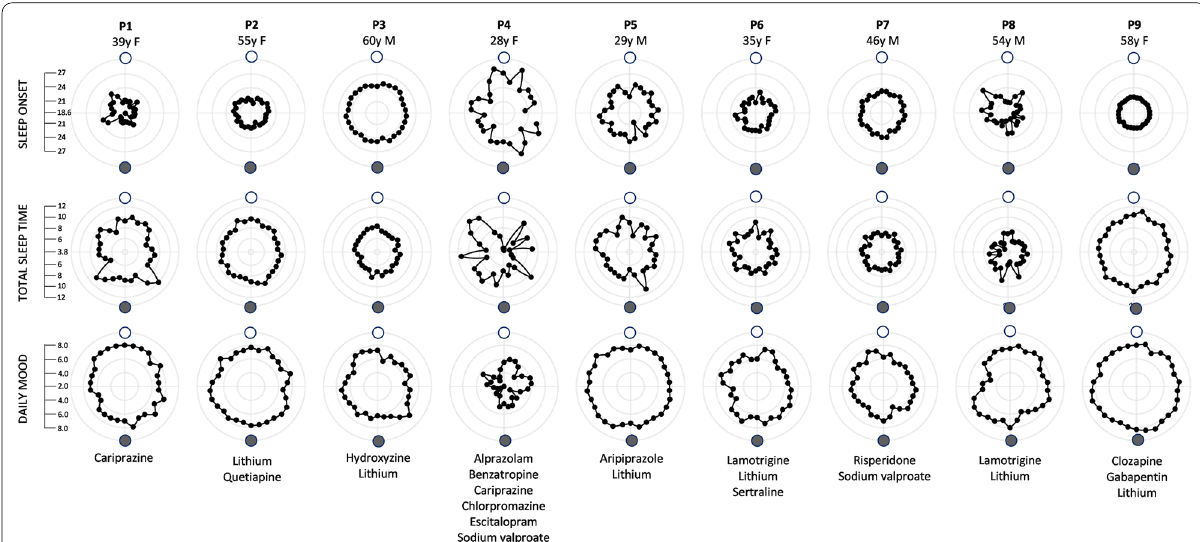
Fig. 1 Circular plots of the average sleep onset time (clock time), total sleep time (hours), and daily mood ratings (1-worst mood to 10-best mood) for each participant, averaged across all available months relative to the lunar illuminance cycle. The full moon is shown as a white circle and the new moon as a gray circle. Each participant’s age and sex are listed at the top, with medications they were taking during the study listed below. Missing sleep data for P4 reflects this participant skipping sleep one